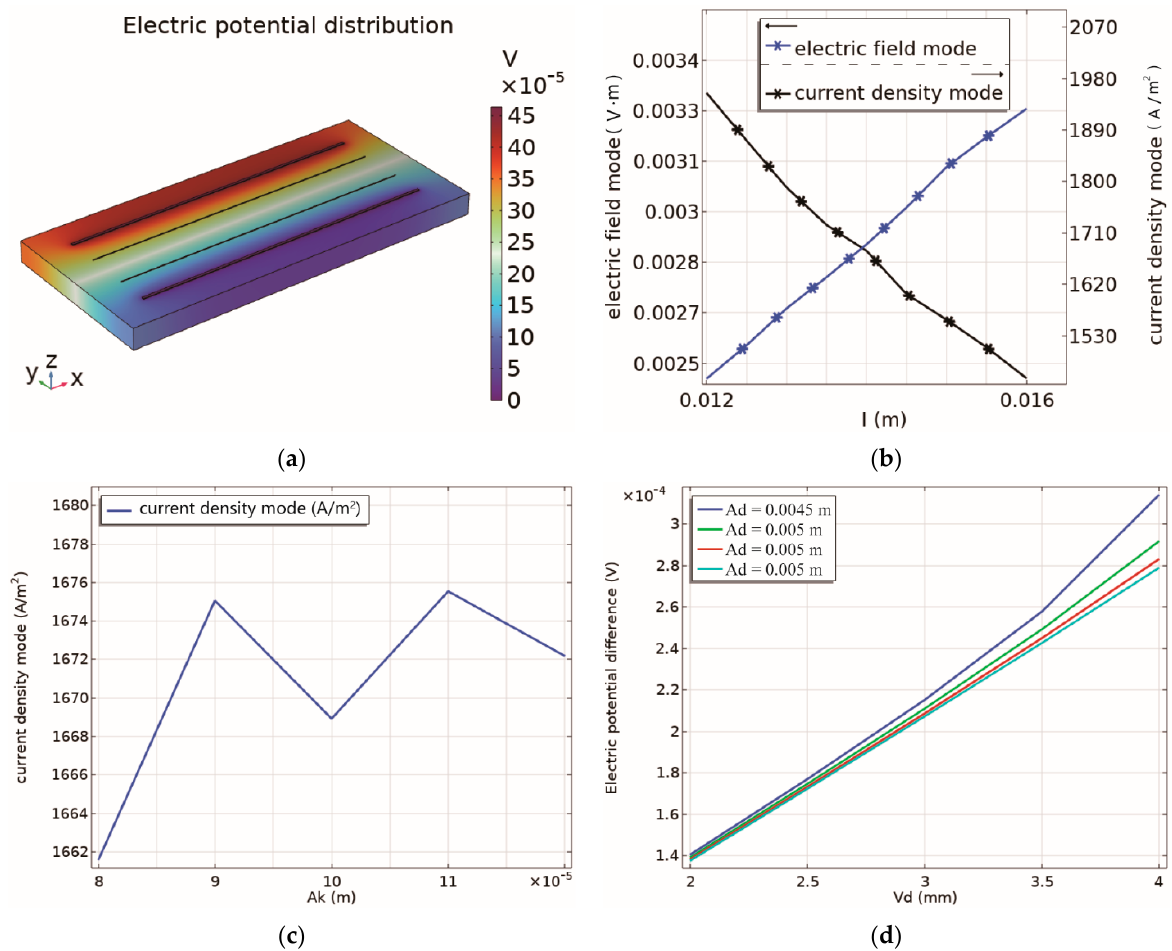
Figure 3. ( a ) The distribution of electric potential; ( b ) the effect of electrode length on current density and electric field strength; ( c ) the effect of current electrode width on current density; ( d ) the relationship between electrode spacing and voltage electrode potential.